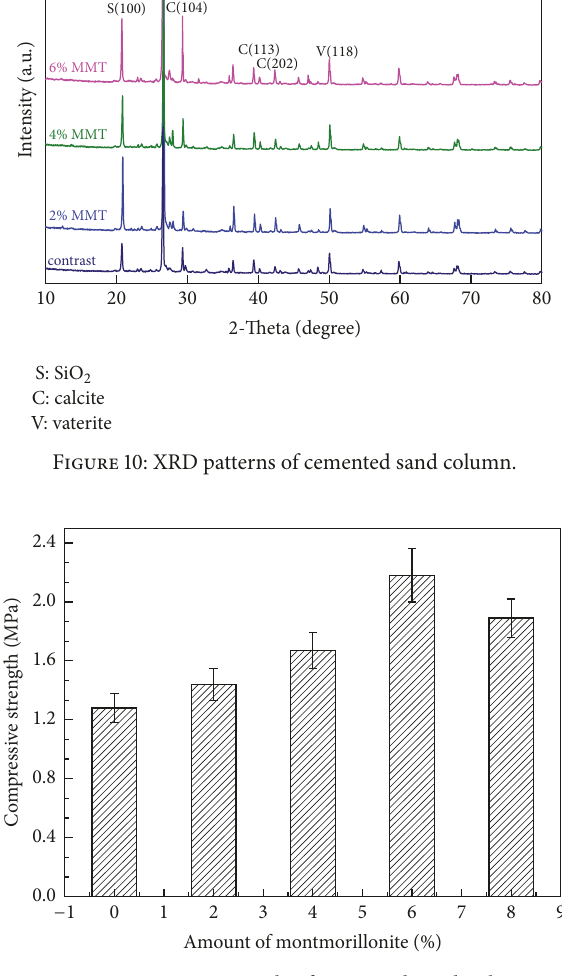
Figure 11: Compressive strength of cemented sand column with different concentrations of